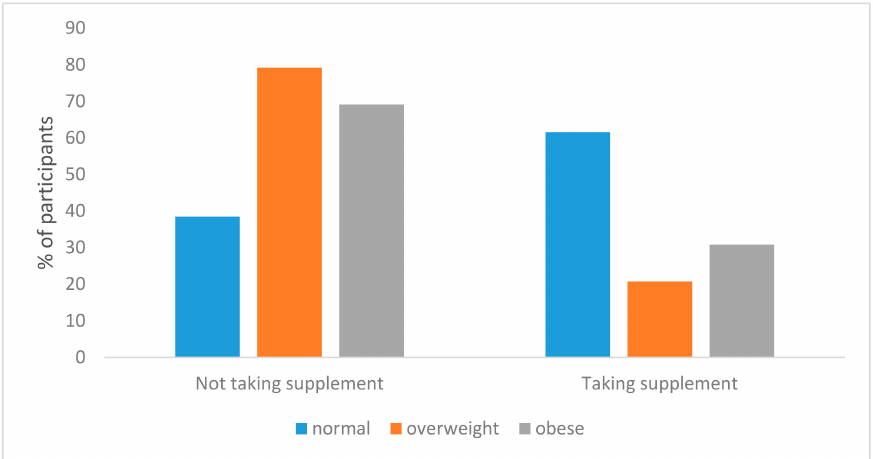
Figure 2. Supplement intake with respect to body mass index (BMI).